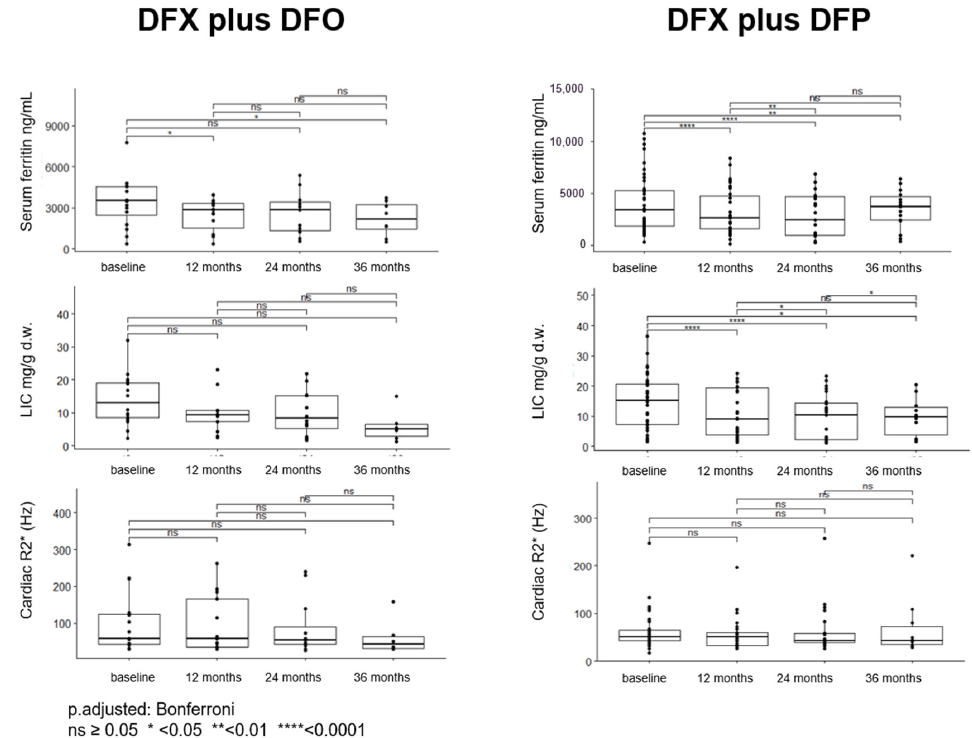
Figure 1. Overall efficacy data for combination iron chelation treatments of deferasirox (DFX) plus desferrioxamine (DFO) and DFX plus deferiprone (DFP). Data are displayed as point distribution and box plots reporting median and quartiles.